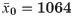
Pre-depuration (a) and during depuration (b) probability distributions, with x¯0=1064 NoV cpg, and σ0 = 1.645.This variability corresponds to the worst case scenario where φ = 95% (Eq 5). Fig (a) splits the distribution’s area into four sections, and states probabilities for each section. Fig (b) shows probability distributions at t = 0 hrs (——), t = 50 hrs (– – –), t = 100 hrs (⋯) induced by depuration decay rate b = 0.01339. Note the different vertical axis scales. Inset bar plot shows the respective changes in section probabilities for each time point corresponding to domain values in Fig 1(a).